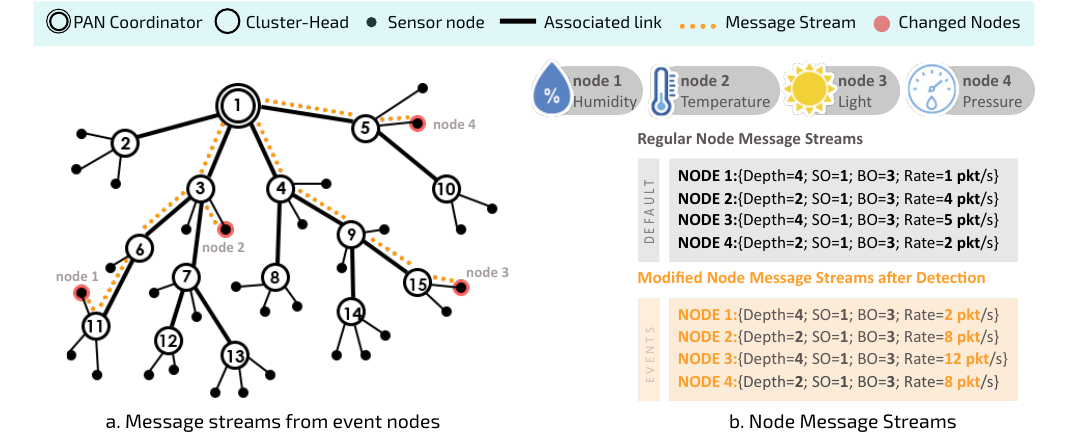
Figure 3. The critical events of nodes and the structure of messages stream